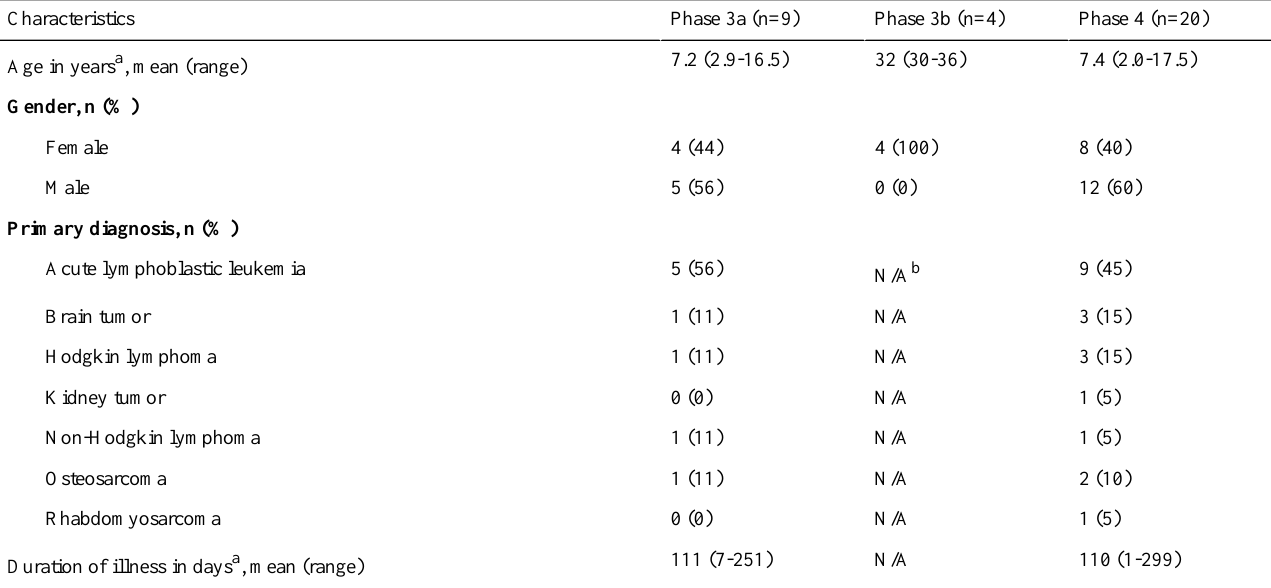
Table 1. Baseline demographics and disease characteristics of participants who were included in the development and evaluation of the